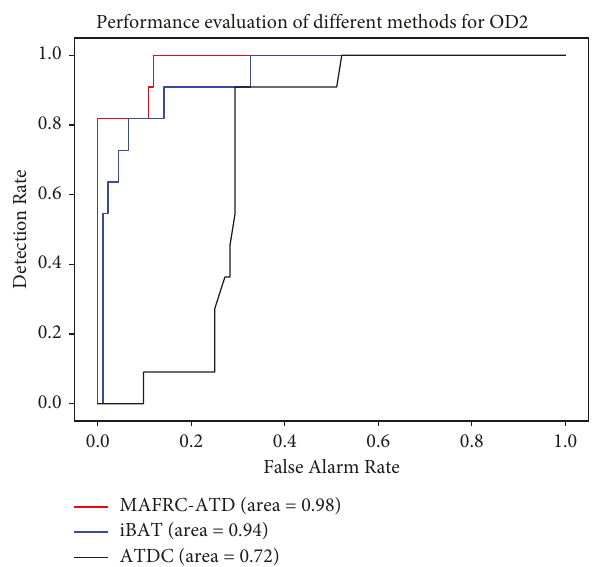
Figure 5: The performance evaluation on anomalous trajectories detection regarding OD